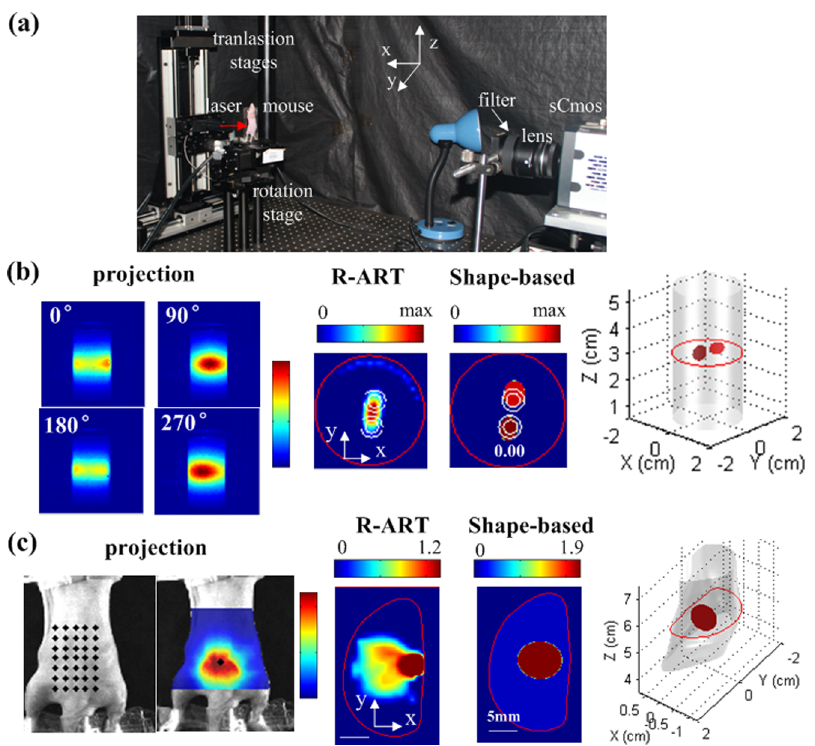
Figure 8. Physical experiments. (a) The full angle fluorescence molecular tomography system developed in-house. (b) Physical phantom experiment. Two fluorescence inclusions were placed closely together inside a cylinder phantom with a 0.10 cm edge-to-edge distance. The white circles denote the inner (solid line) and outer (dash line) boundaries of the real inclusions. (c) In vivo experiment. A fluorescence inclusion was embedded inside a nude mouse. The grid of black dots overlaid on the mouse represents the excitation light sources. For the slice images in (b) and (c), the red circle denotes the boundary of the imaged object, and every two slice images are at the same height, as depicted by the red circle in the corresponding 3D image.